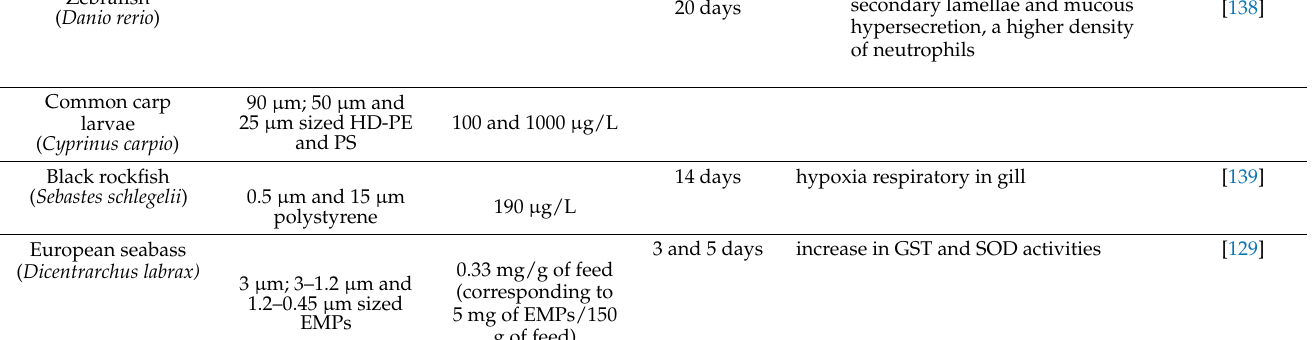
Table abbreviations: polystyrene (PS), polyester (PES), polypropylene (PP), polyamides (PA), polyethylene (PE), hidh density polyethylene (HD-PE), polypropylene (PP), polyvinyl chloride (PVC), environmental microplastics (EMPs). Bussolaro et al. [136] found that polystyrenes NPs decreased the viability of rainbow trout gill epithelial cells in a concentration-dependent manner. On the other hand, Hu et al. [132] conducted an in vivo study by exposing adult Japanese medaka ( O. latipes ) to polyester (PES) and polypropylene (PP) MPs fibers. By means of scanning electron microscopy (SEM), observations of gills increased mucus, denuding of epithelium on arches, and fusion of primary lamellae were observed. Histologic sections revealed: aneurysms